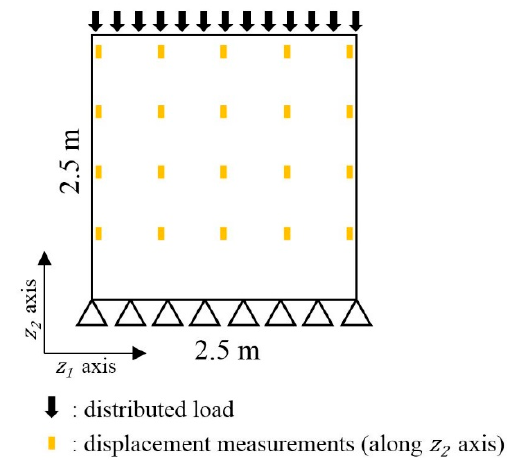
Figure 12. Static loading test setting and displacement sensor locations.